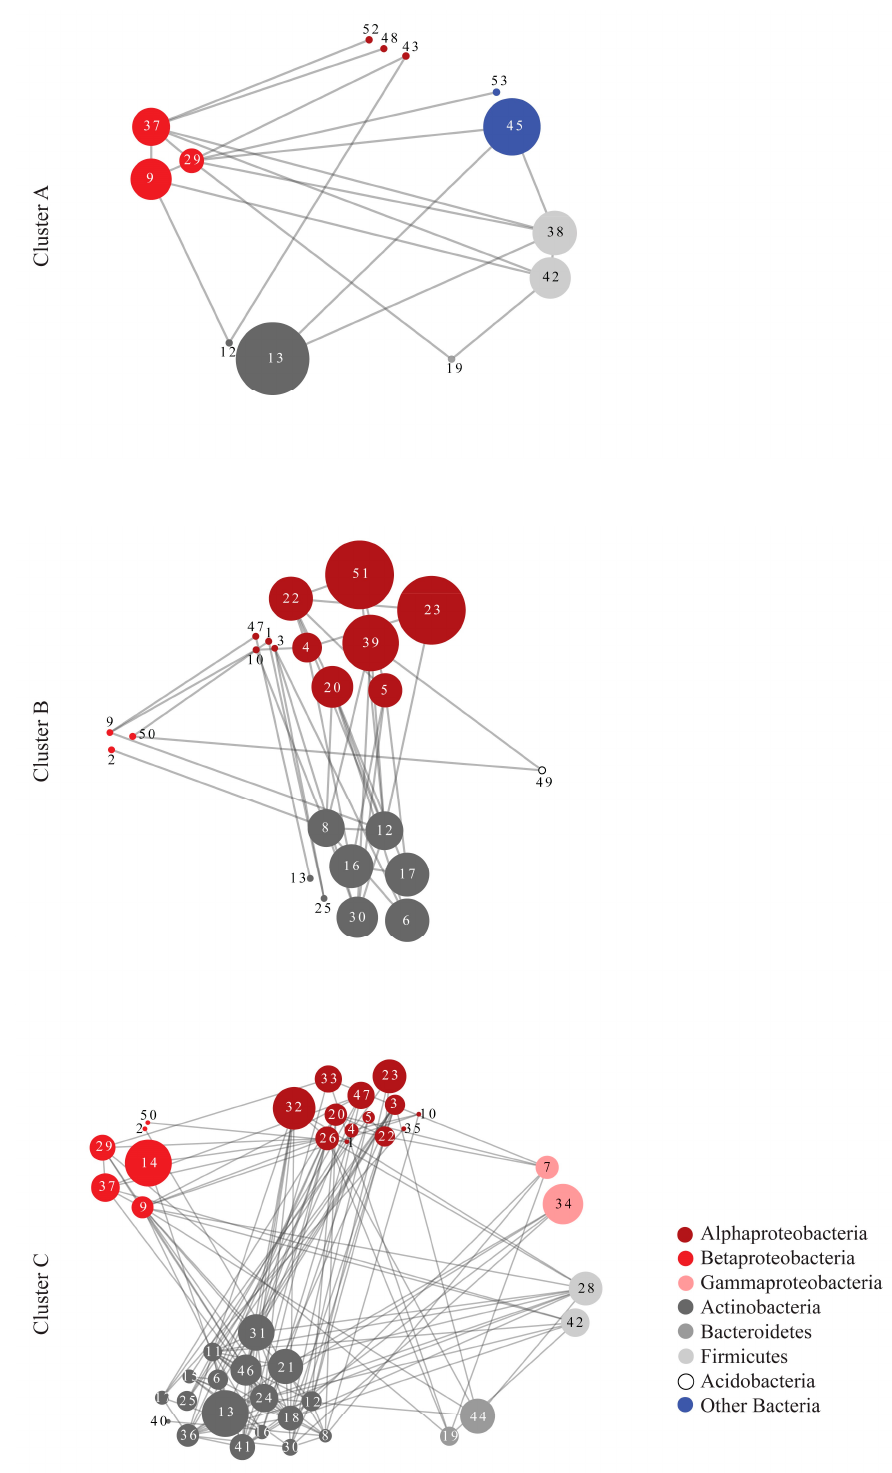
Figure 5. Networks of Maximal Information Coe ffi cient (MIC) correlations (edges) based on the abundance of the OTUs (nodes) responsible for the formation of the three clusters in Figure 3, according to SIMPER analysis. The di ff erent colors represent di ff erent taxonomic groups. The numbers within each node correspond to the serial number of each OTU in Supplement Table S2. The size of the nodes is analogous to the clustering coe ffi cient of each OTU with larger nodes representing key OTUs for the network, in terms of connectivity and centrality.